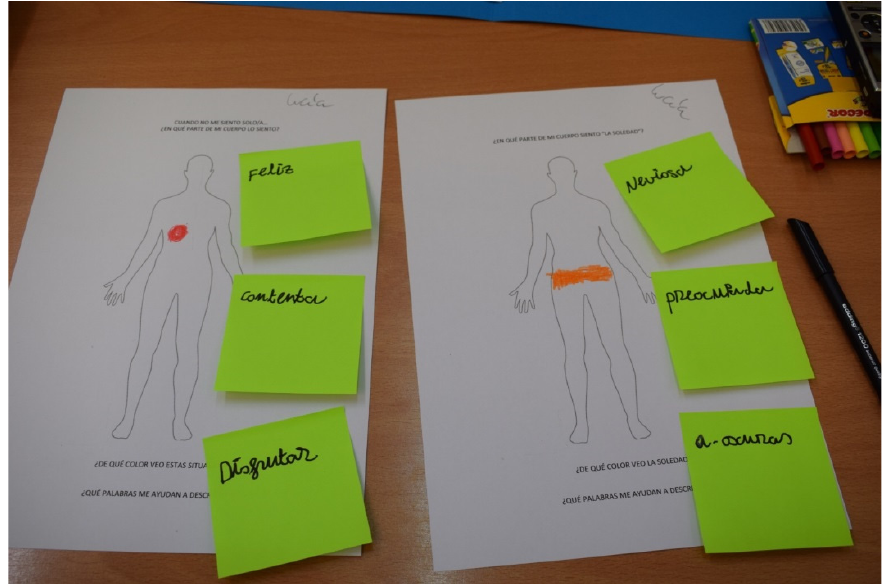
Figure 3. Personal cartography example. Left: “When I don’t feel lonely—Where do I feel it in my body? What colour would represent it? What words would I use?” (Response: “happy, content, enjoy”.) Right: “Where do I feel loneliness? What color would represent it? What words would I use?” (Response: “nervous, worried, in the dark”).